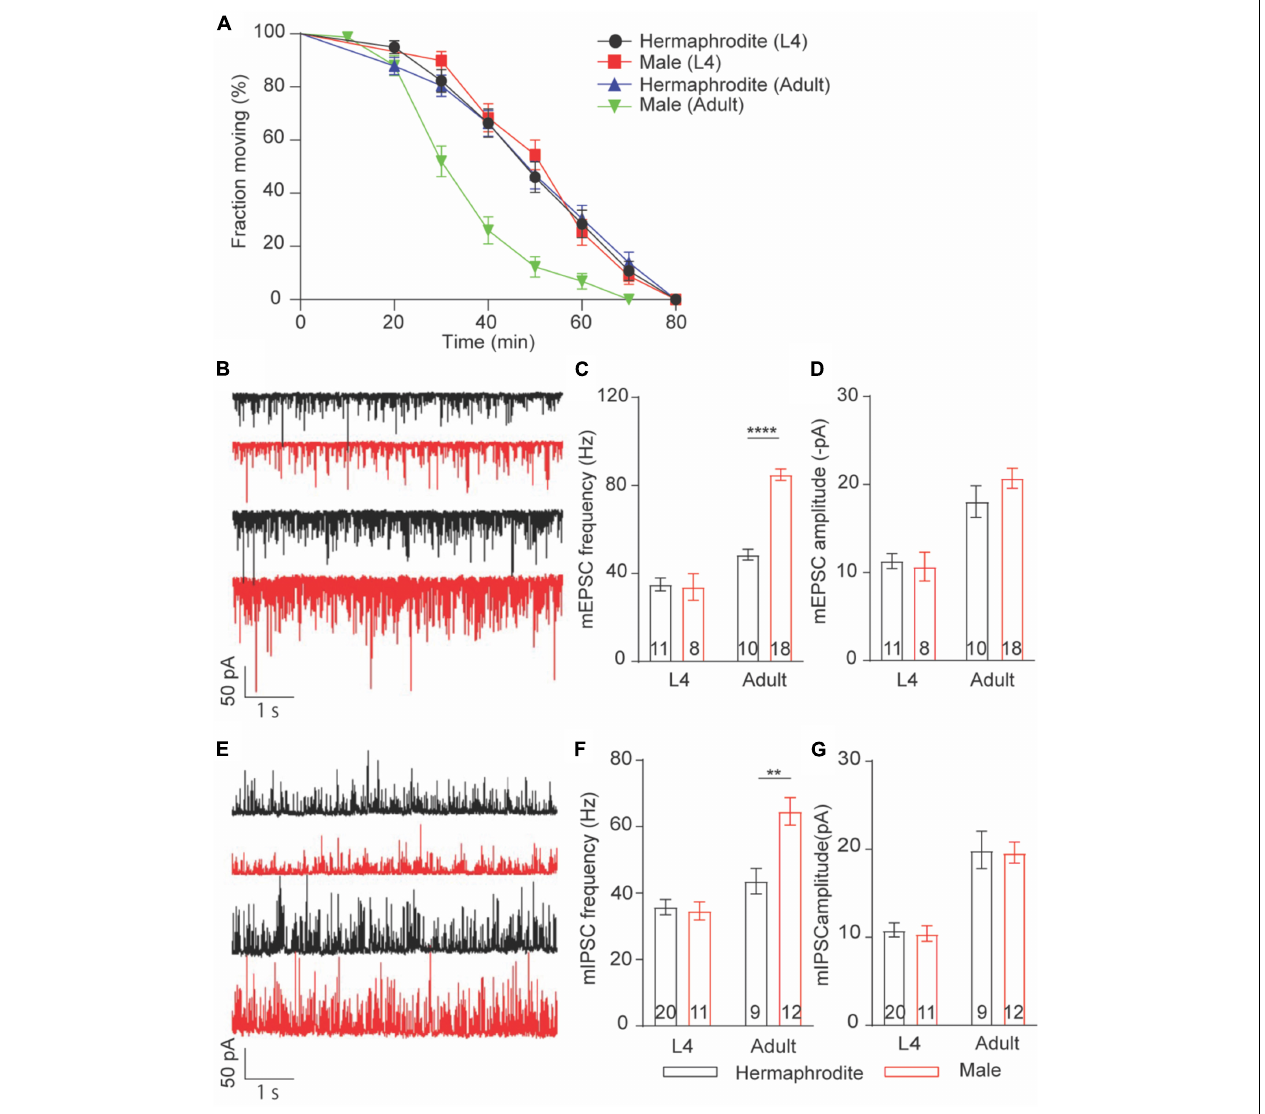
FIGURE 4 | Sex-specific calcium sensitivities of neurotransmitter release at the NMJs are developmental stage-dependent. (A) The time course of 1 mM aldicarb-induced paralysis with hermaphrodites and males at the larval stage L4 and adult stage. (B) Sample traces of mEPSC recorded from the NMJs of hermaphrodites and males at the larval stage L4 and adult stage. Bar graph of the frequency (C) and the amplitude (D) of mEPSC recorded from the NMJs of hermaphrodites and males at the larval stage L4 and adult stage. (E) Sample traces of mIPSC recorded from the NMJs of hermaphrodites and males at the larval stage L4 and adult stage. Bar graph of the frequency (F) and the amplitude (G) of mIPSC recorded from the NMJs of hermaphrodites and males at the larval stage L4 and adult stage. Sample sizes ( n numbers) are indicated in the bars of each graph. All data are represented as mean ± SEM (** p < 0.01, **** p < 0.0001, t